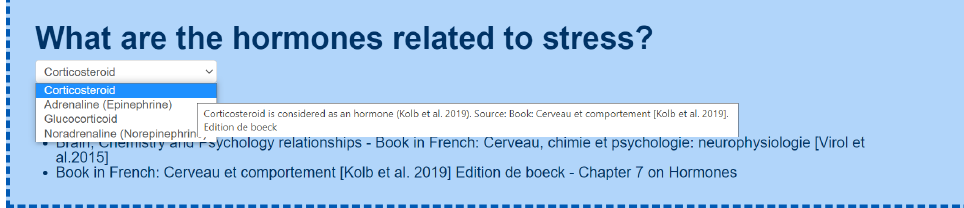
Figure A5. Example of a subset of the taxonomy of hormones related to stress [59,65].